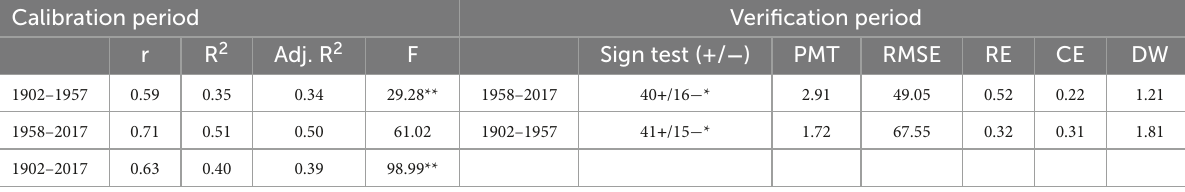
TABLE 2 Calibration and verification statistics of reconstructed PPT JJA .